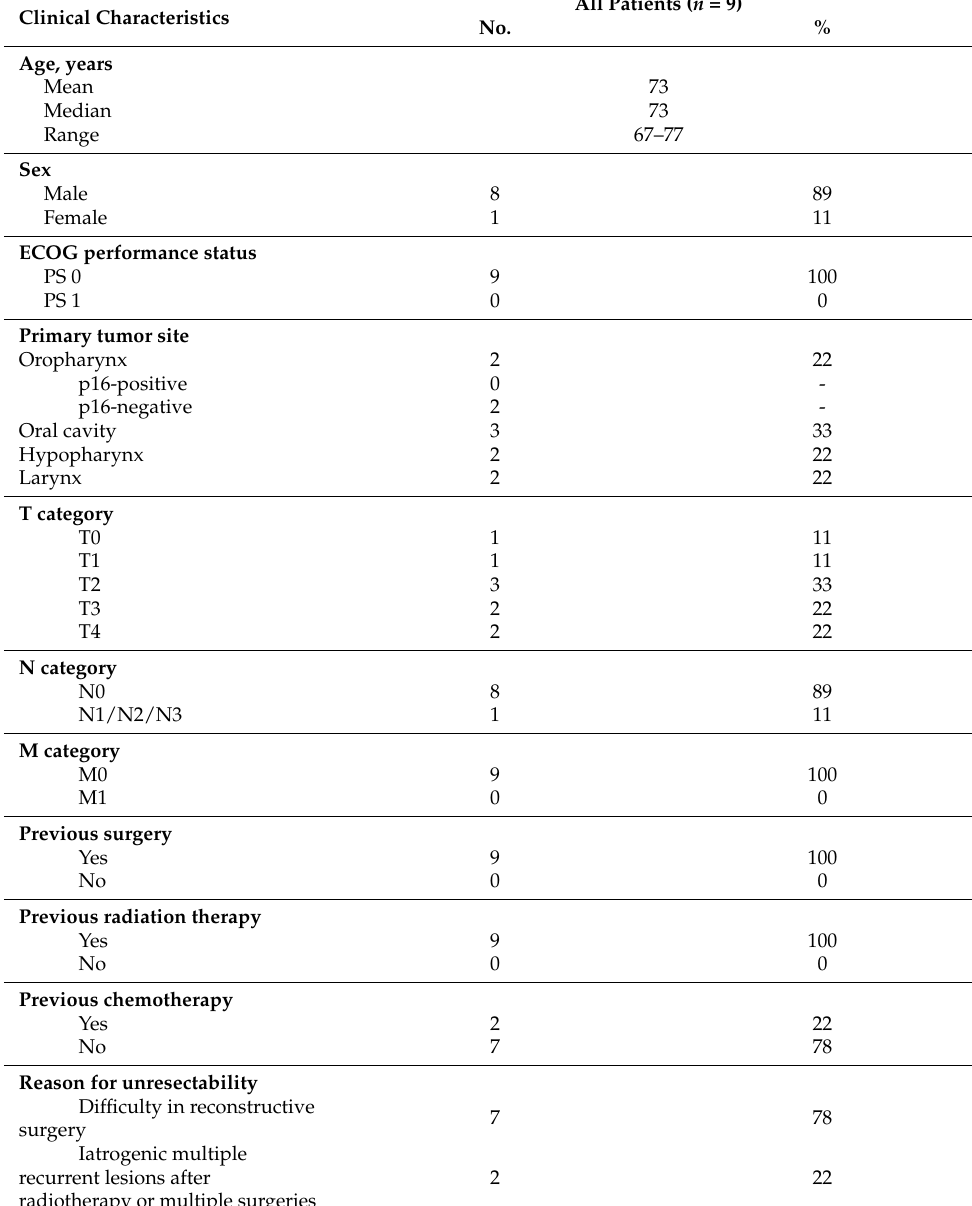
Table 1. Clinical